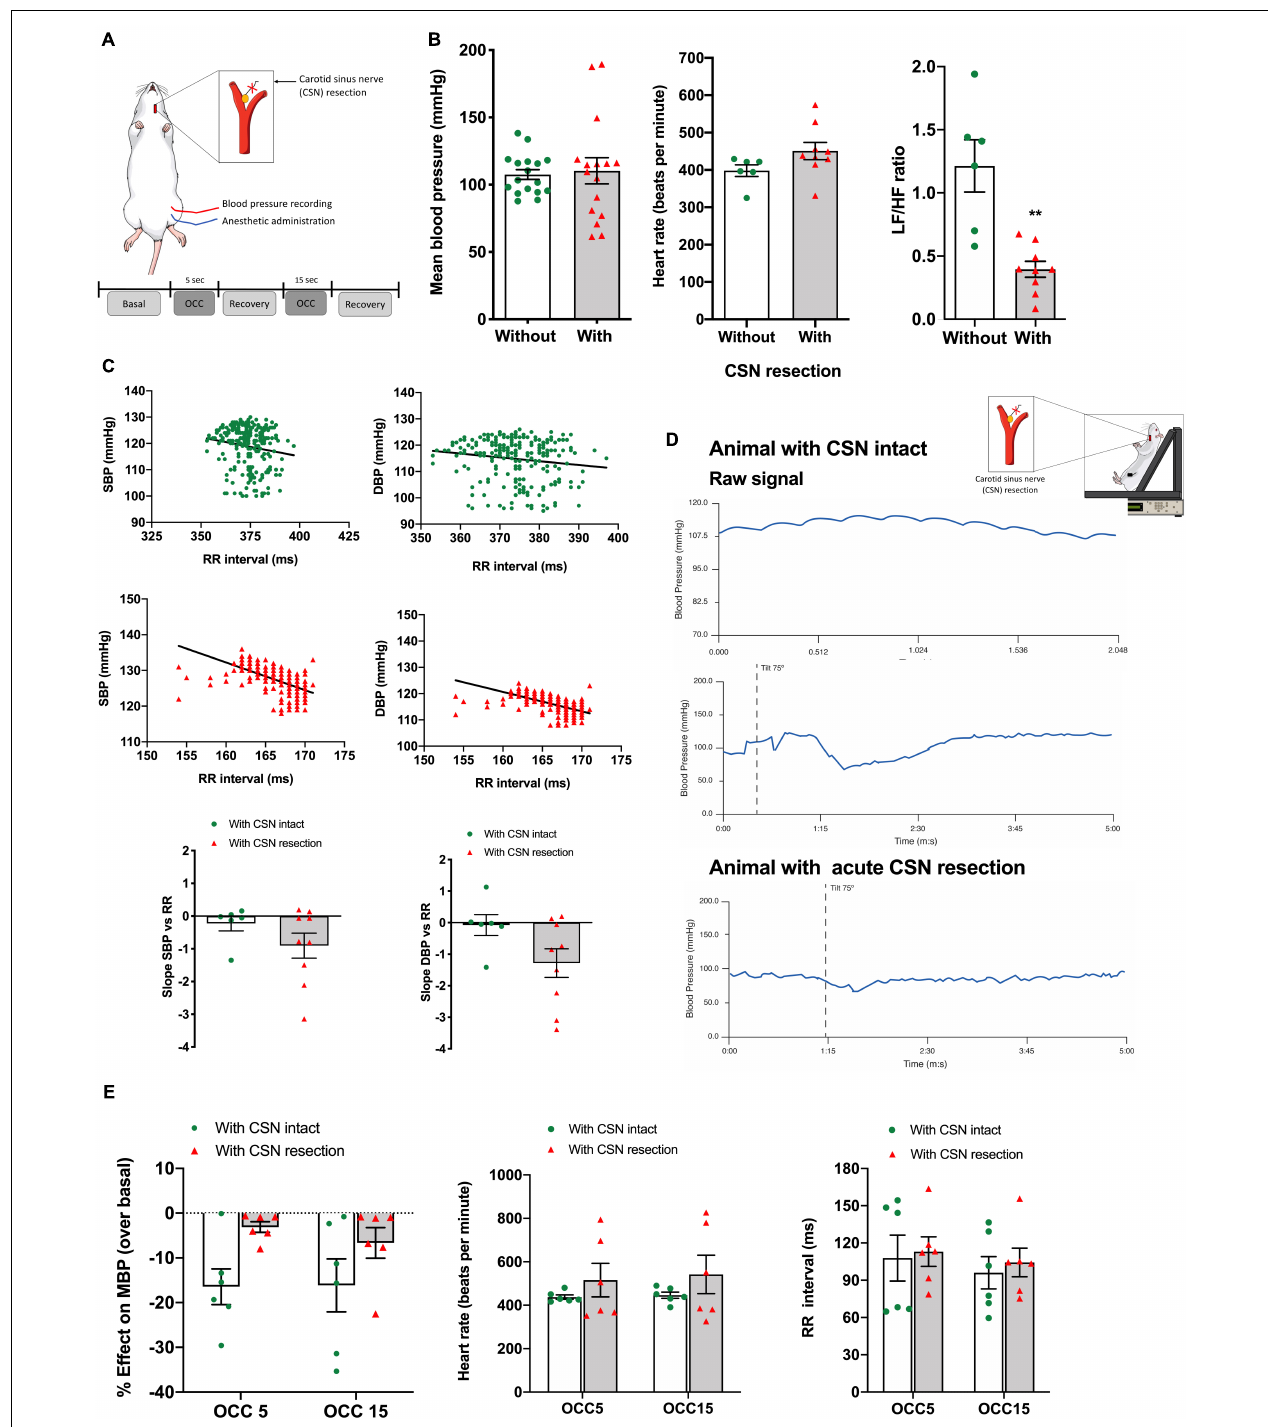
FIGURE 2 | Effect of CSN acute resection on blood pressure, HR, autonomic function, baroreflex sensitivity, and blood pressure responses in basal conditions and in response to ischemic hypoxia in anesthetized animals. (A) Schematic representation of the protocol used to assess the impact of CSN on the physiological variables evaluated in basal conditions (normoxic atmosphere) and in response to ischemic hypoxia assessed as OCC of 5 and 15 s, (B) respectively, from left to right, the effect of bilateral CSN denervation on MBP (left panel), HR (middle panel), and autonomic function (right panel) assessed by the spectral analysis of the HR and expressed as the ratio between the Lf and Hf of the spectra in anesthetized rats (control; n = 17; CSN denervated, n = 16). (C) Top graphs show representative SBP and DBP correlations with the RR intervals in rats with CSN intact (green, n = 6) and with CSN resection (red, n = 9) obtained in the experimental setting shown in (A)